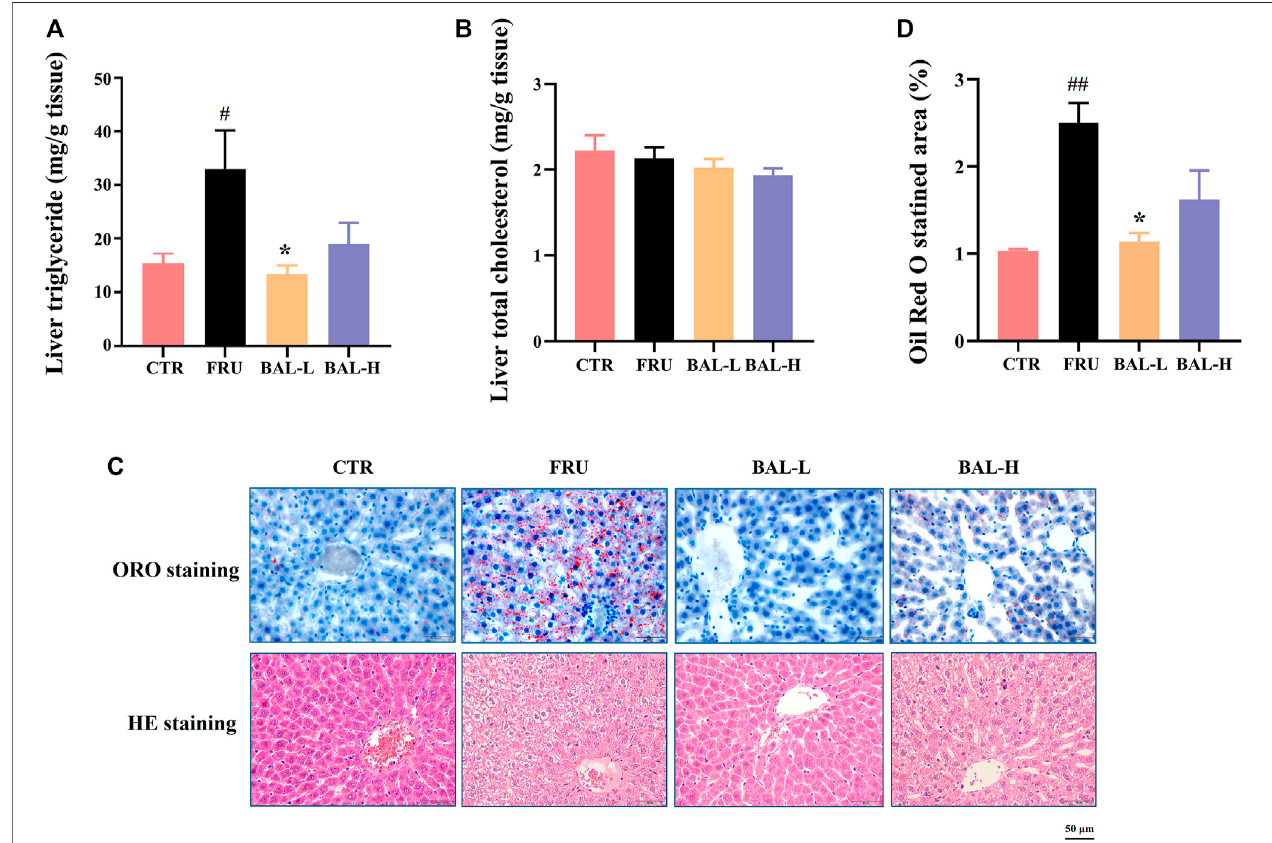
FIGURE 2 | Effect of BAL treatment on hepatic lipid accumulation in fructose-fed rats. (A) TG in liver. (B) Hepatic content of TC. (C) Pathological morphology of liver by ORO staining and HE staining. (D) Relative quanti fi cation of ORO staining area by fi gure J software. Data were represented as Mean ± SEM (n = 6/group), ## p < 0.01 , # p < 0.05 , compared with CTR; **p < 0.01 , *p < 0.05 , compared to